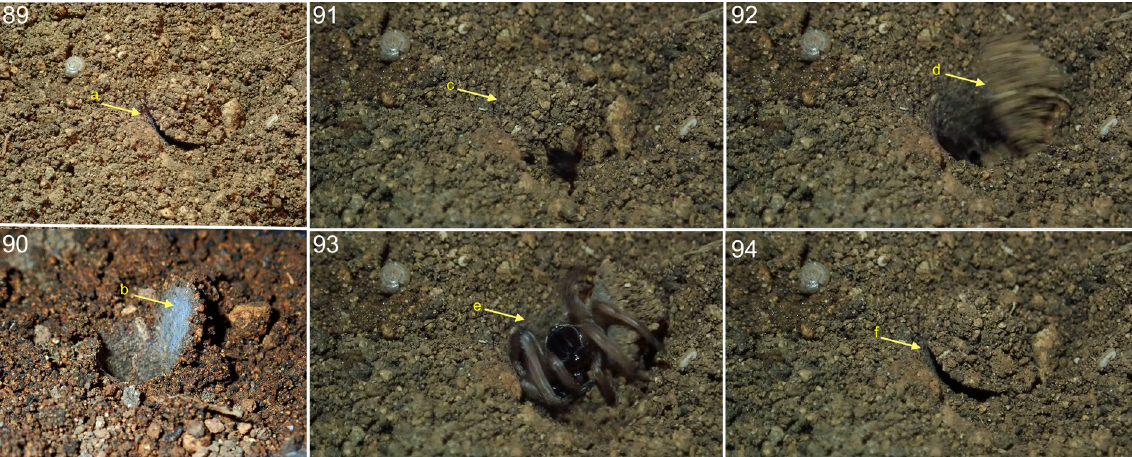
90 . Opened trapdoor (b). 91 . Closed trapdoor (c). 92 . Flash-attack by spider as a reaction on subtle movements near the trapdoor (d). 93 . Spider retreats after attack (e). 94 . Trapdoor remains ajar after retreat